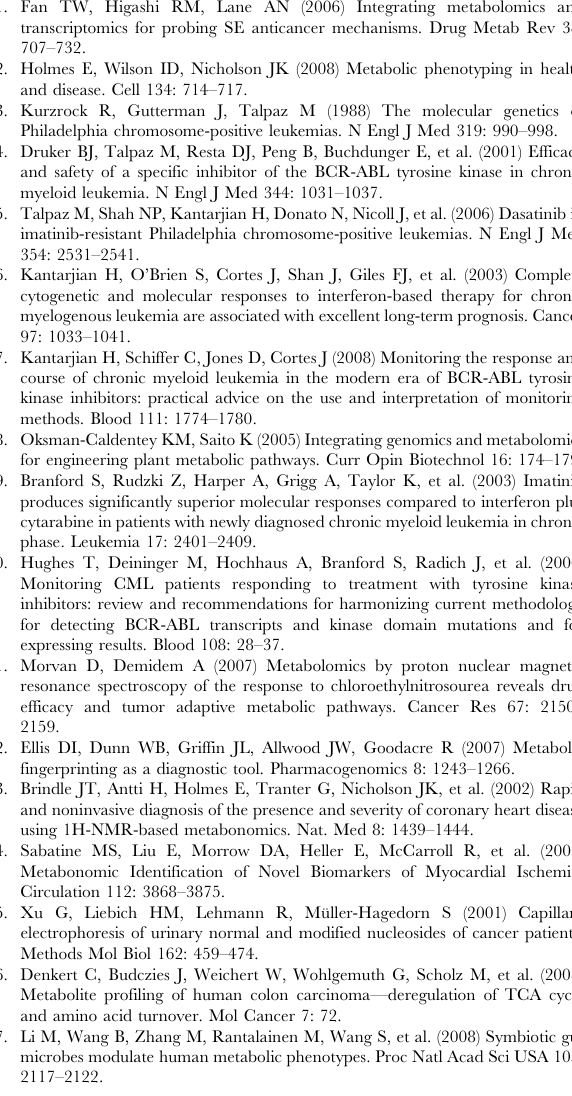
Table S2 The relative abundance of the identified compounds/ peaks differentiating RCML BC from RCML CP patients. Table S3 Primer pairs used for